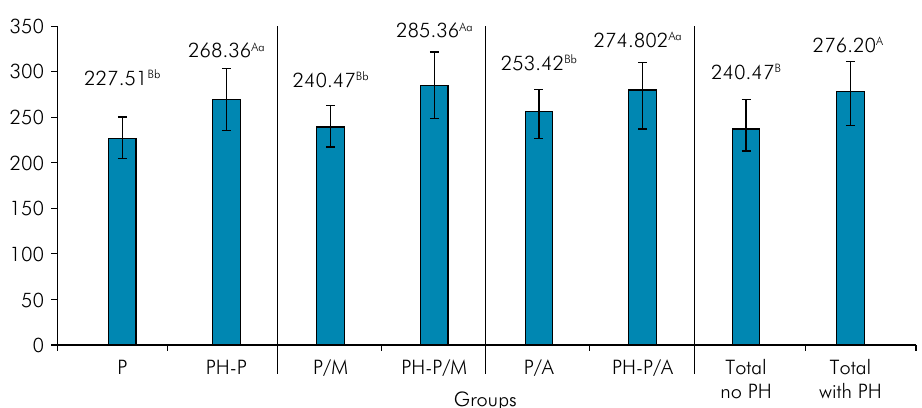
Figure 2. Flexural strength test results for